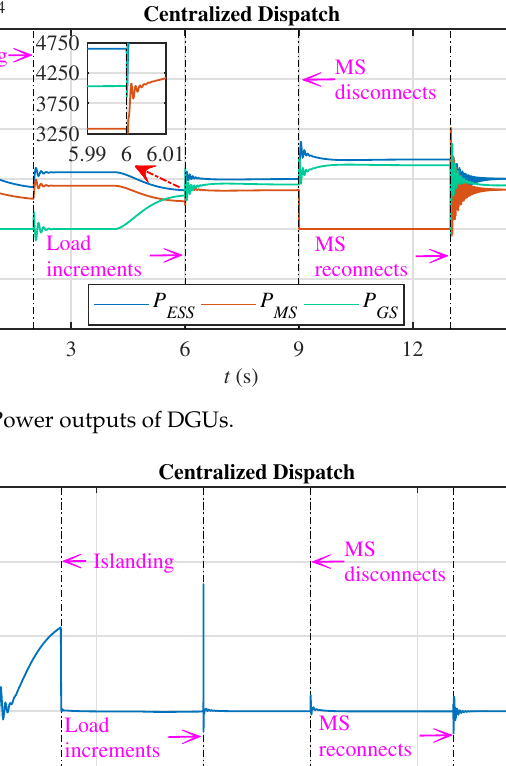
Figure 11. The optimal power dispatch references for DGUs.